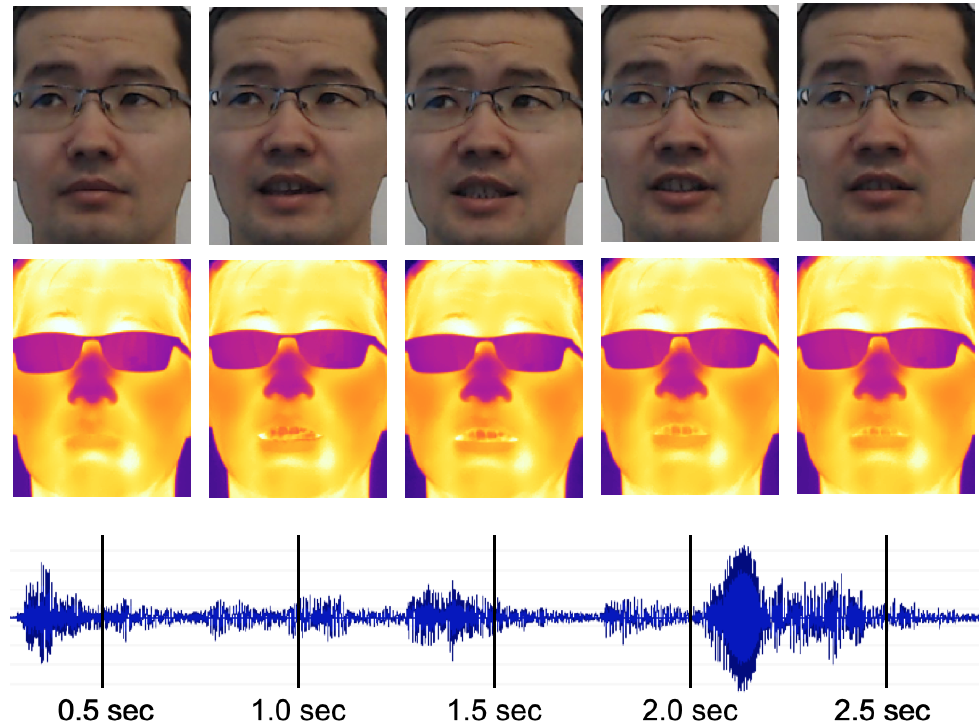
Figure 5. Snapshots from the visual and thermal streams with 0.5-second intervals during the utterance of “stop the kitchen fan from